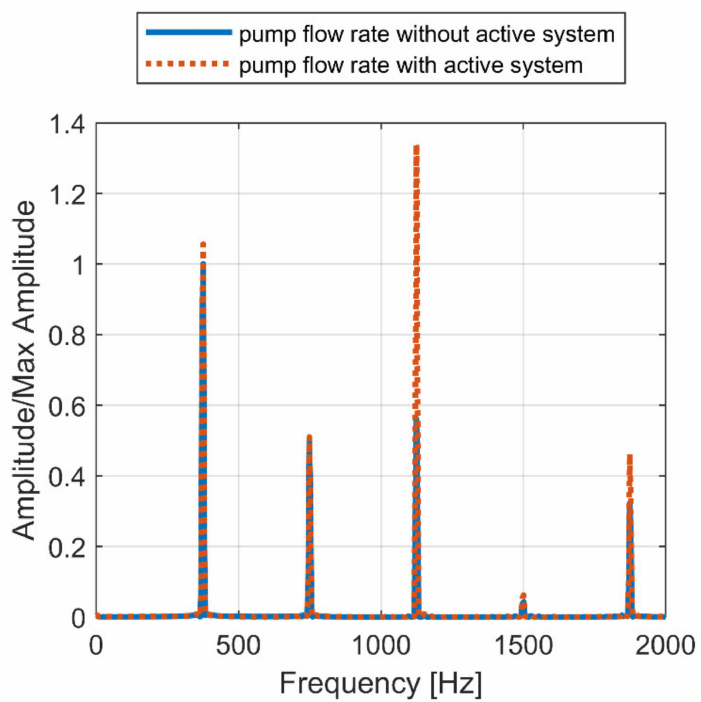
Figure 20. Limited current simulation, section 3: flow ripple FFT at 30 bar, 2500 rpm, 50% swash plate